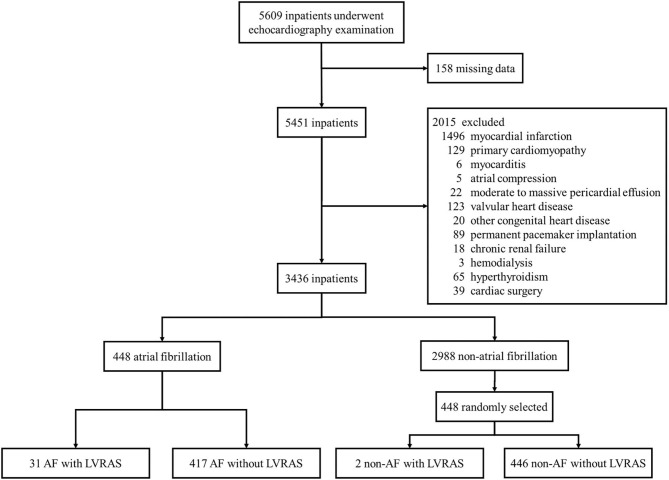
Sample recruitment from cardiology department patients. AF, atrial fibrillation; LVRAS, left ventricular-to-right atrial shunt.